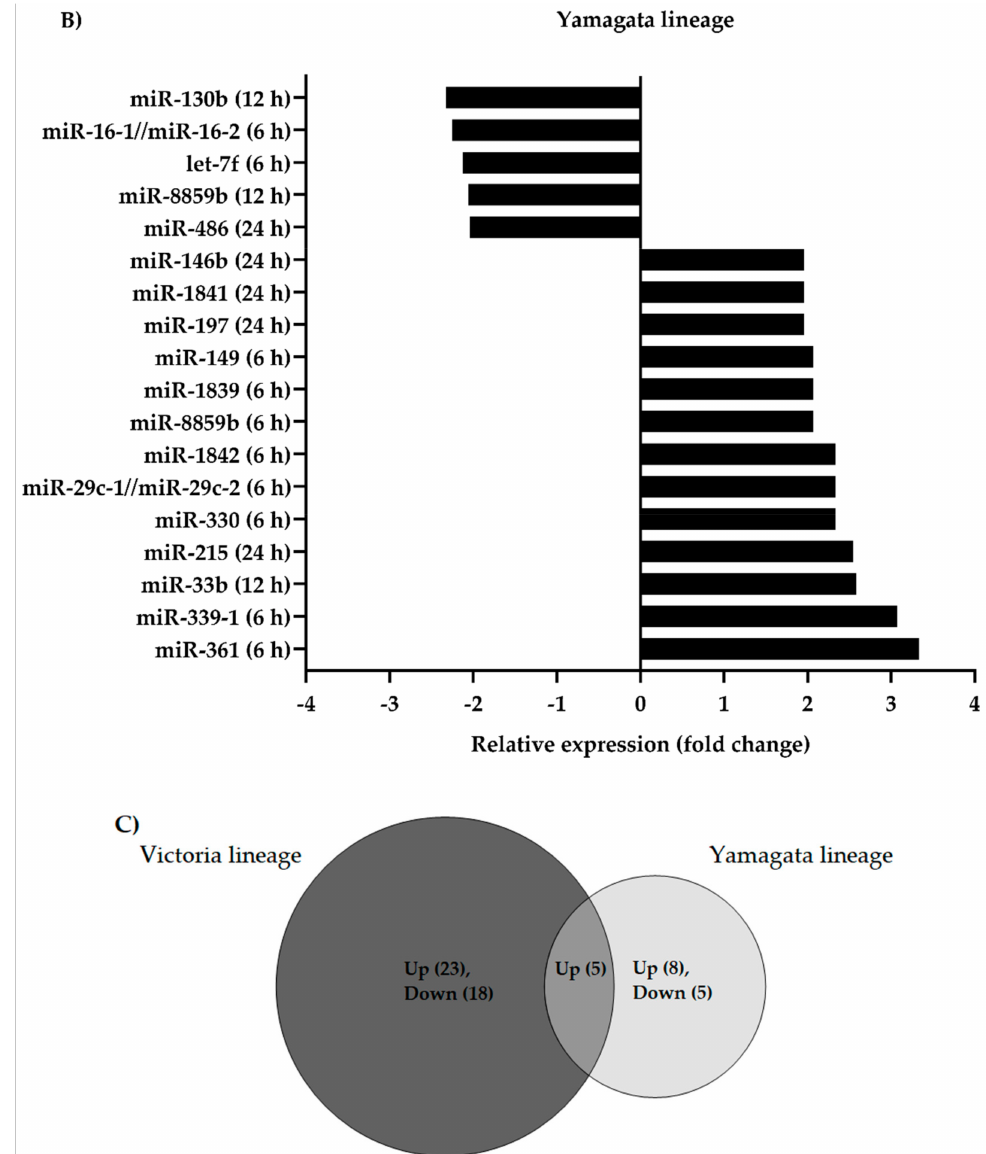
Figure 1. The miRNA expression profiles in each lineage of influenza B virus infection. Madin–Darby canine kidney (MDCK) cells were infected with mock, Victoria, or Yamagata lineage at multiplicity of infection (MOI) = 0.01, and collected at 6, 12, 24 hpi. ( A ) Forty-six microRNAs were dysregulated in the cells infected with Victoria lineage. ( B ) Eighteen microRNAs were in the cells infected with Yamagata lineage. ( C ) Venn–Euler diagram shows unique and overlapped microRNA expressions in Victoria and Yamagata